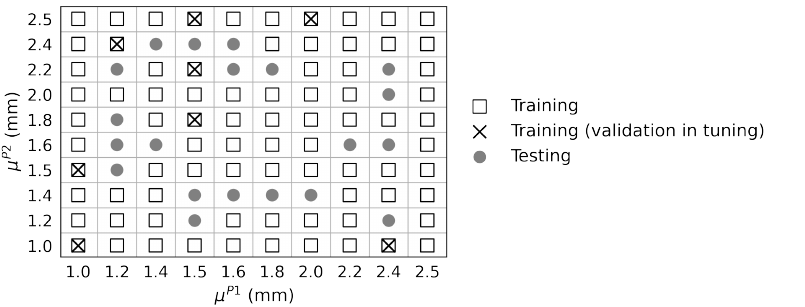
Figure 12. Sample distribution in parametric space of training and testing sets for model H 3 .